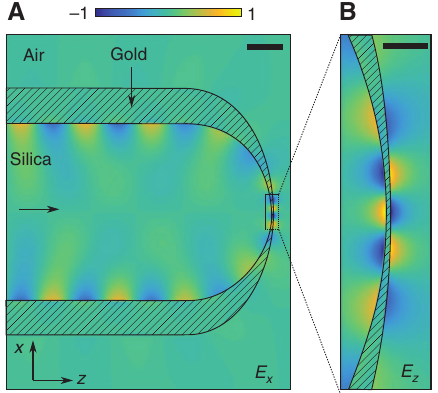
Figure 12: Hemispherical fiber-based nanoprobe that consists of a spherical fiber end-face coated by a tapered metal gold film. The two plots show 2D simulation of the spatial distribution of the electric field in the vicinity of the hemisphere ( λ = 632.8 nm). The thickness of the gold film changes from 200 to 5 nm toward the center of the hemisphere. An antisymmetric mode (with respect to the transverse electric field) that incident from the left-handed side excites a plasmonic mode that leads to energy concentration at the location of smallest gold film thickness. (A) Distribution of the transverse electric field ( E ). Scale bar, 200 nm. (B) Distributions of x the longitudinal electric field component E at the end of the hemi- z sphere. Scale bar, 100 nm. Calculations performed by the author, after Ref.